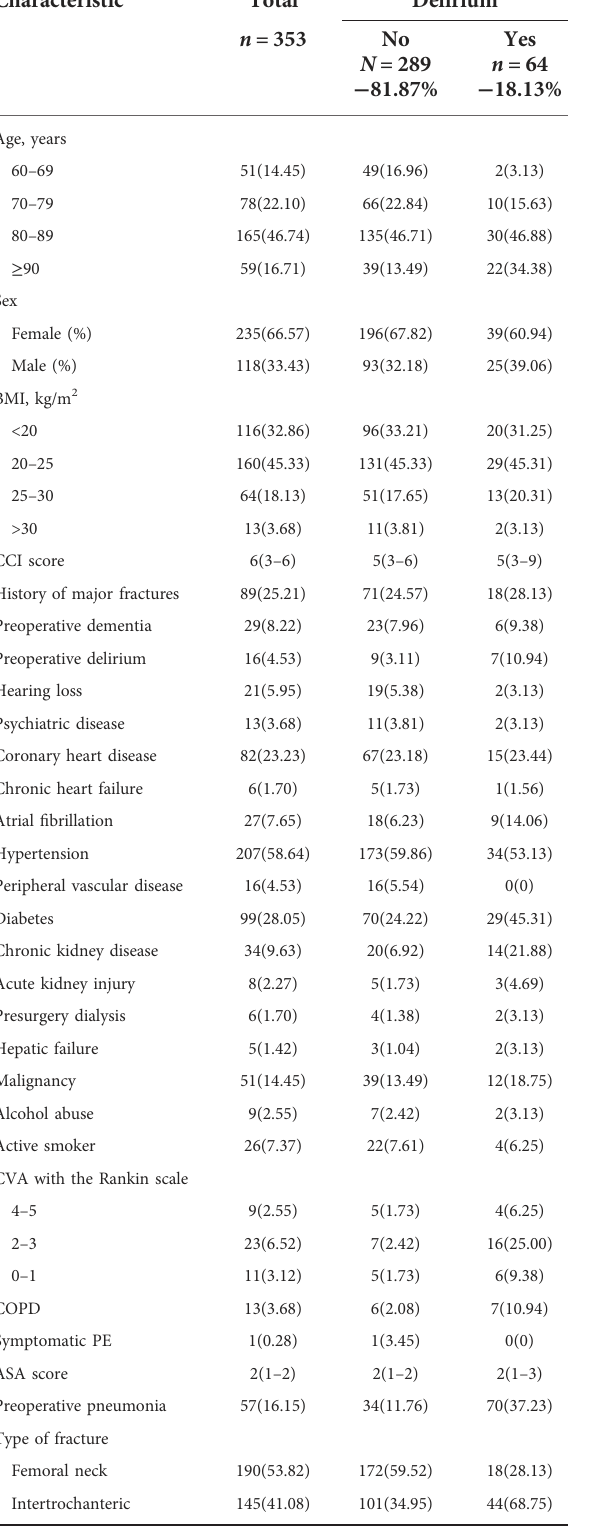
TABLE 4 Baseline characteristics of patients in the validation cohort who did or did not develop postoperative delirium. Characteristic